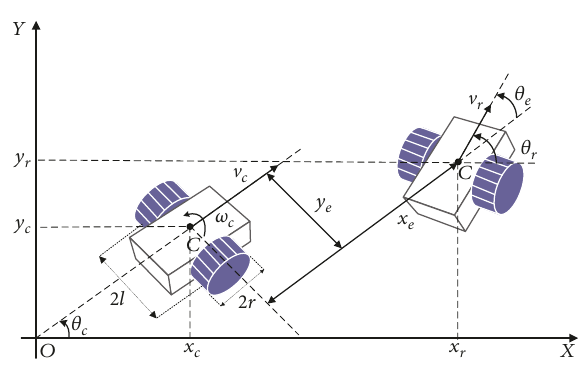
Figure 1: Wheeled mobile robot pose